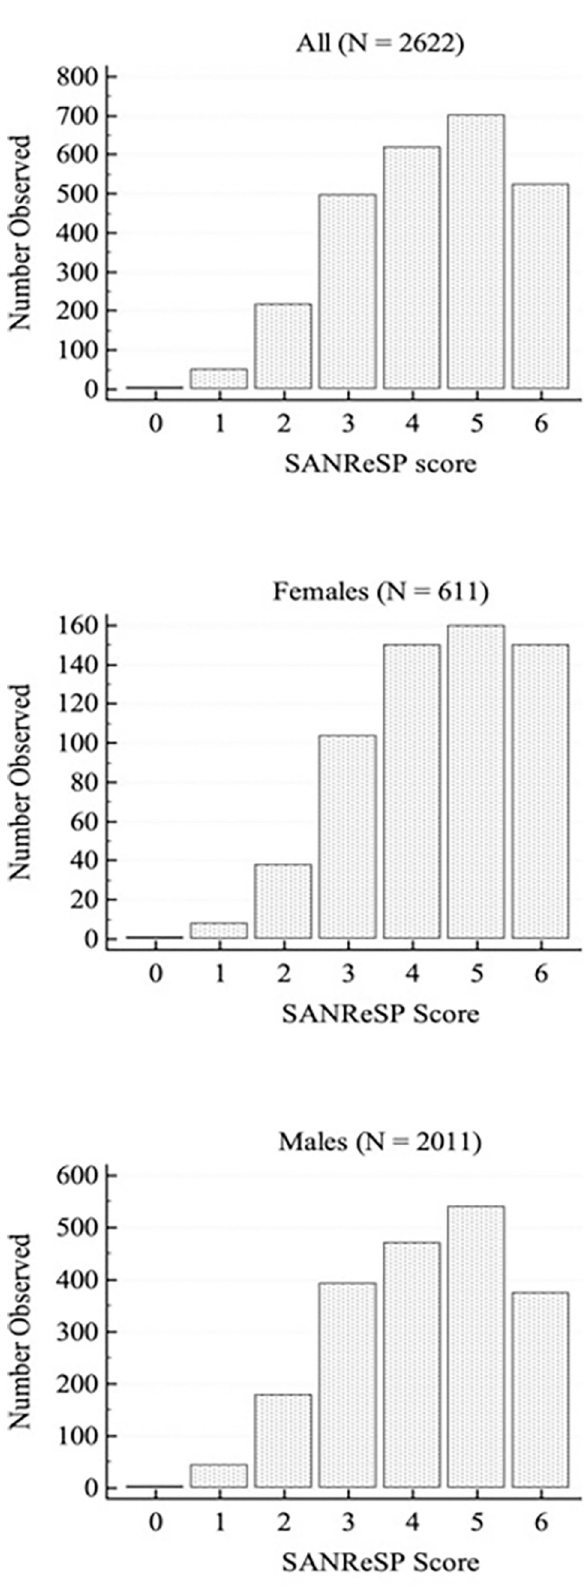
Fig 2. Distribution of patients according to their SANReSP score for males and females. https://doi.org/10.1371/journal.pone.0276217.g002 PLOS ONE | https://doi.org/10.1371/journal.pone.0276217 October 14,